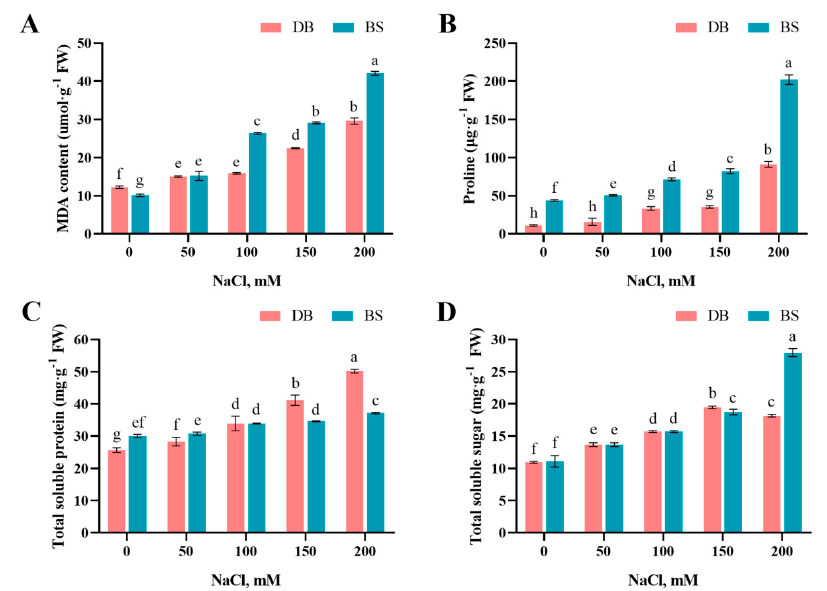
Figure 2. Effect of different NaCl concentrations on ( A ) malondialdehyde (MDA) content, ( B ) pro- line, ( C ) total soluble sugar, and ( D ) total soluble protein of H. syriacus ‘Duede Brabaul’ (DB) and H. syriacus ‘Blueberry Smoothie’ (BS). According to Duncan’s test, different lowercase letters (a–g) in- dicate significant differences ( p < 0.05) between different treatments.